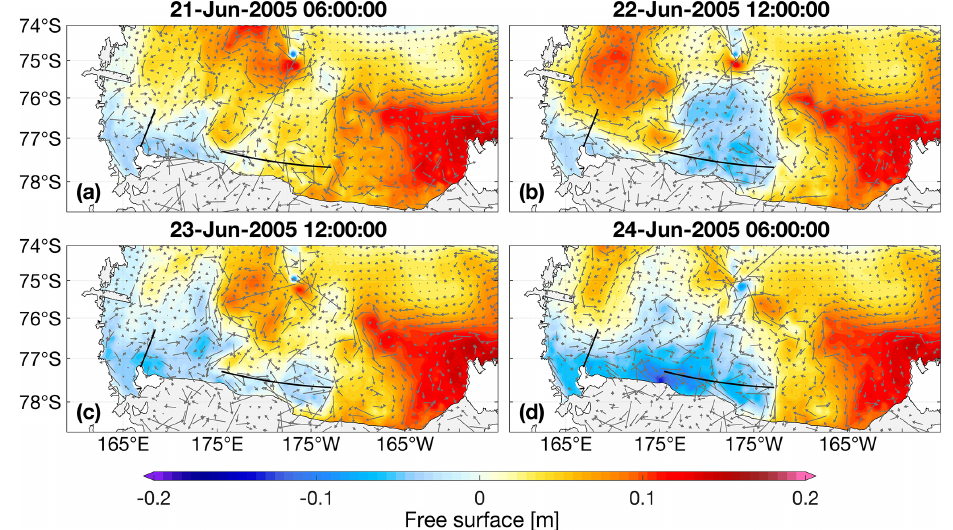
Figure 14. (a–d) Spatial distributions of free surface (colored shading) and barotropic geostrophic currents (gray arrow) in the Ross Sea region at four selected time moments of MESO (indicated by the magenta triangles in Fig. 11a and b). The black lines indicate the S1 and S3